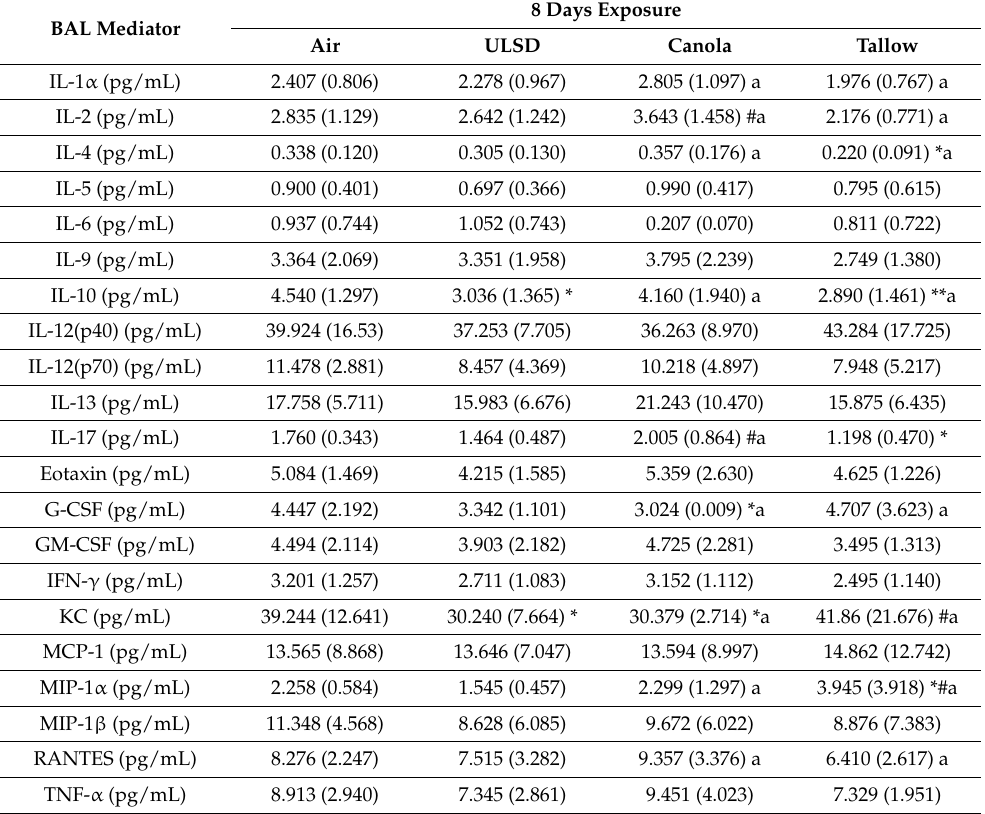
Table 3. Mean (standard deviation) mediator levels in bronchoalveolar lavage fluid for mice exposed to Air, ULSD, Canola, or Tallow biodiesel exhaust for 2 hr/day for 8 days ( n = 12). Data were analyzed using general linear modeling methodologies.